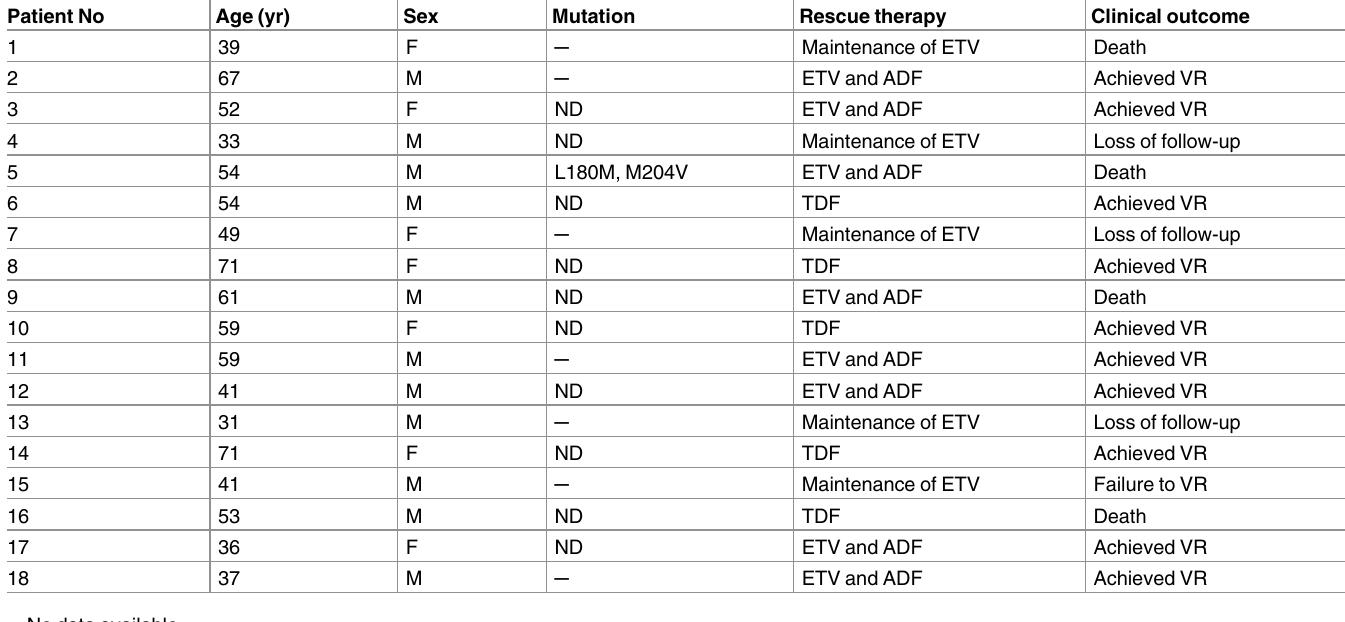
Table 3. Baseline characteristics and clinical outcome of patients experienced virological